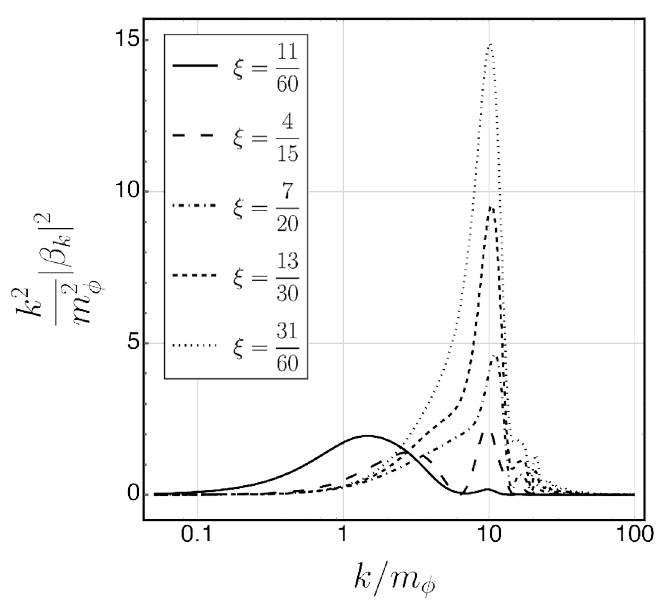
Figure 4 . Representative spectral particle production for masses in the regime 10 9 GeV < m < H 0 . We are showing the particular case for m = 7 (cid:2) 10 11 GeV. In these cases the spectral production increases with the coupling term as the resonance e(cid:11)ect becomes more